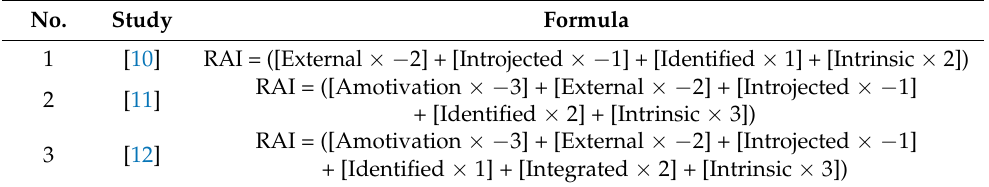
Table 2. Formulas for measuring autonomy via the